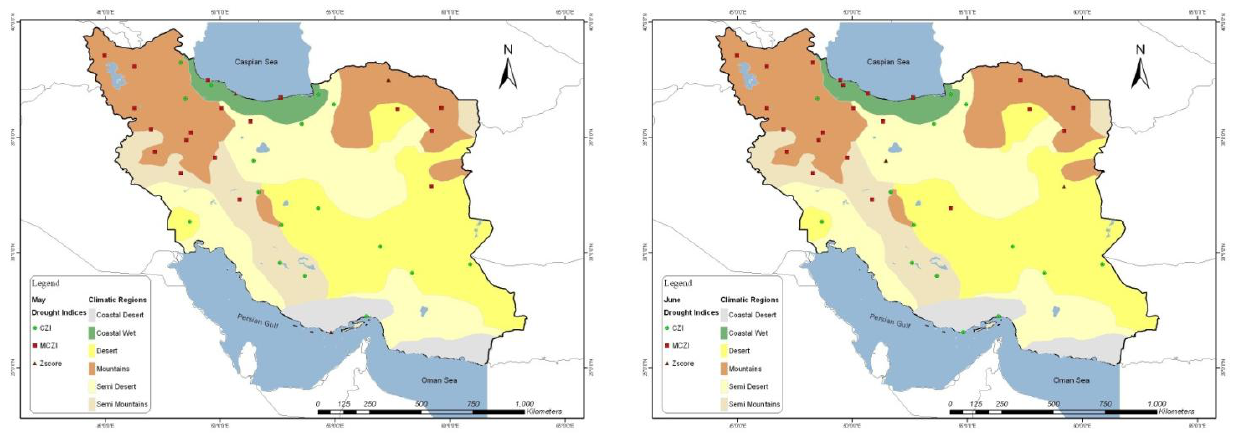
Figure 4. Spatial distribution of monthly drought indices with the best correlation to standardized precipitation index (SPI) for May, June, July and